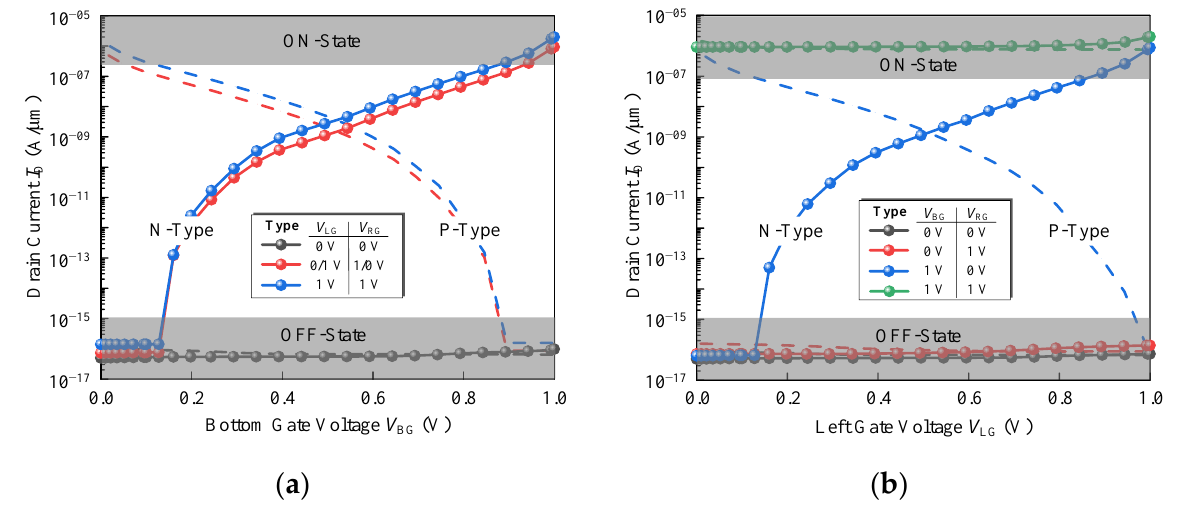
Figure 10. ( a ) I D - V BG and ( b ) I D - V LG curve of the proposed device exhibiting OrAnd behavior. The dotted lines are for N-type device and dashed lines for P-type. The pull-up network of an OrAnd logic gate needs to exhibit AndOr logic behavior, so a three-input TFET with the AndOr logic behavior is needed to be realized. For an AndOr logic device, only the BTBT current in the vertical channel at gate inputs of AB = “10” or AB = “01” needs to be suppressed. Consequently, the device parameters related to the vertical channel can remain unchanged, such as the φ of the left and right gate and T v . It is worth noting that the device is turned on at ABC = “001”, so the coupling in the horizontal should not be enhanced. On the basis of the MAJ logic device, the φ of the bottom gate is reduced to 4.2 eV, and the N S_v is set to N-doped 5 × 10 19 cm − 3 . The BTBT generation rate distribution under different biasing condition is obtained, as shown in Figure 11. As we can see, the BTBT in the horizontal channel is modulated by the V BG only, and the BTBT only occurs near the bottom region in the horizontal channel due to the small threshold voltage of the bottom gate.